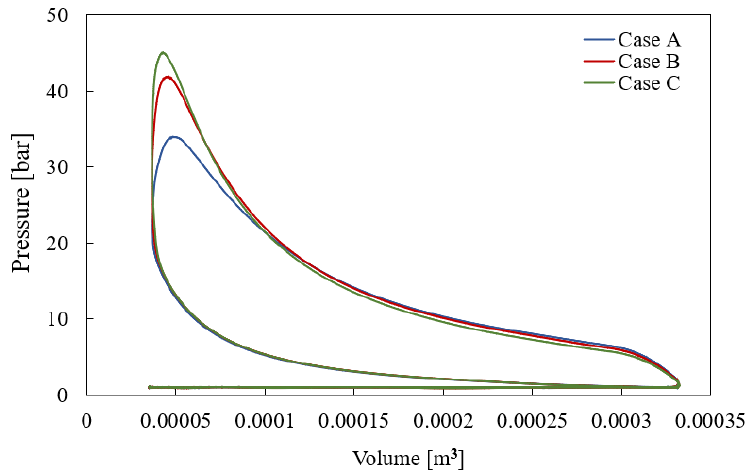
Figure 16. P-V diagram of the working chamber for different cases.